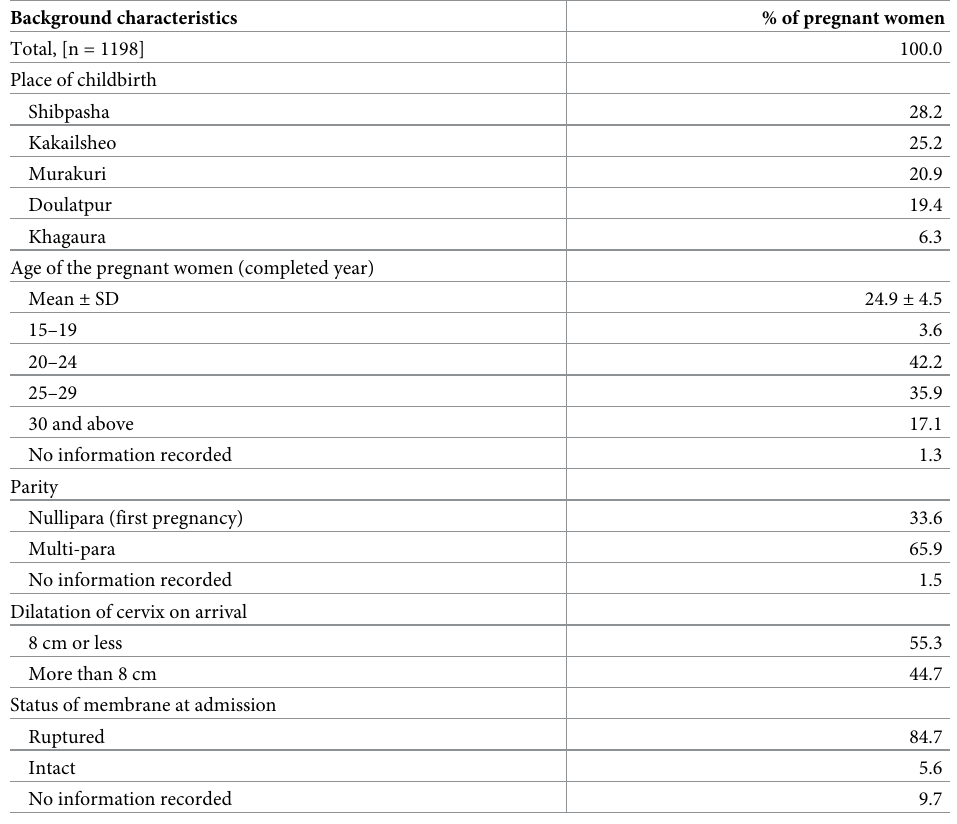
Table 4. Background characteristics of study population. Background